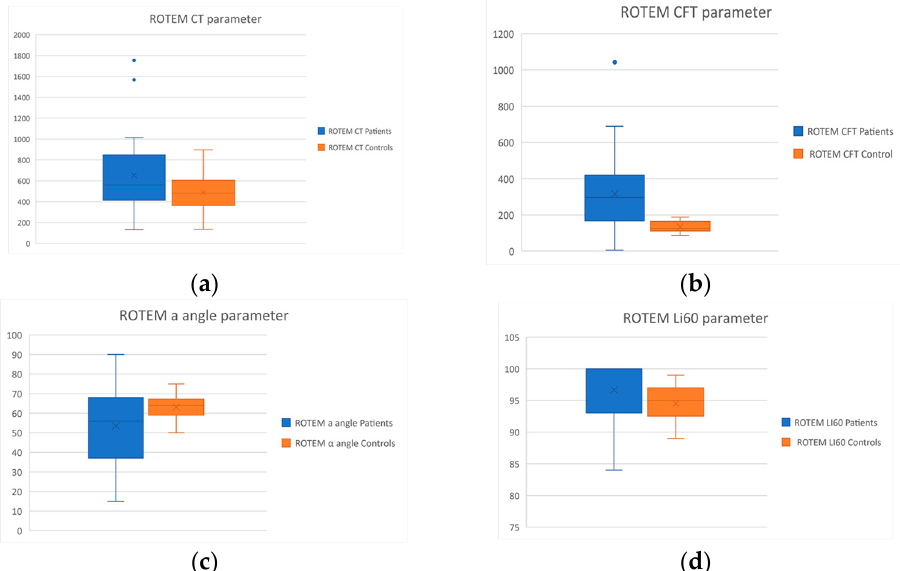
Figure 5. Box and Whisker plots of the results of the ROTEM assay of the patient and control groups. ( a ) depiction of the CT parameter; ( b ) depiction of the CFT parameter; ( c ) depiction of the a angle parameter; ( d ) depiction of the Li60 parameter.